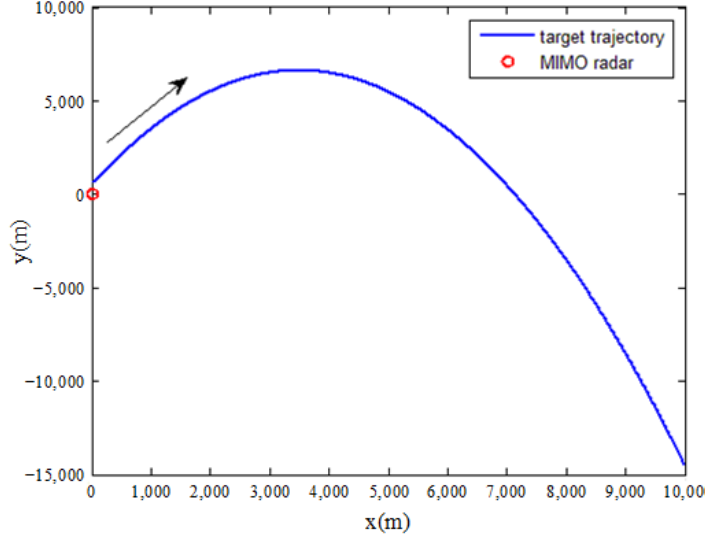
Figure 3. Geometric relationship of the targets and MIMO radar.